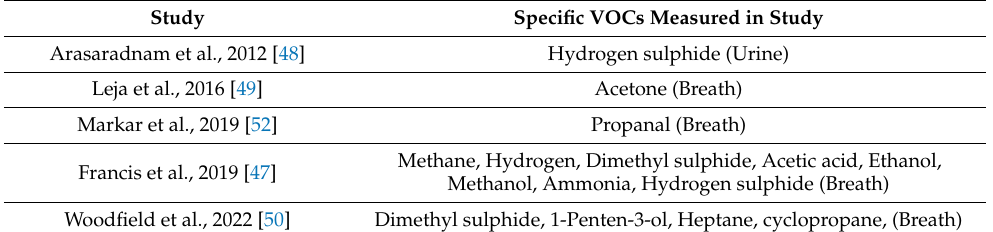
Table 2. Specific chemicals measured in each